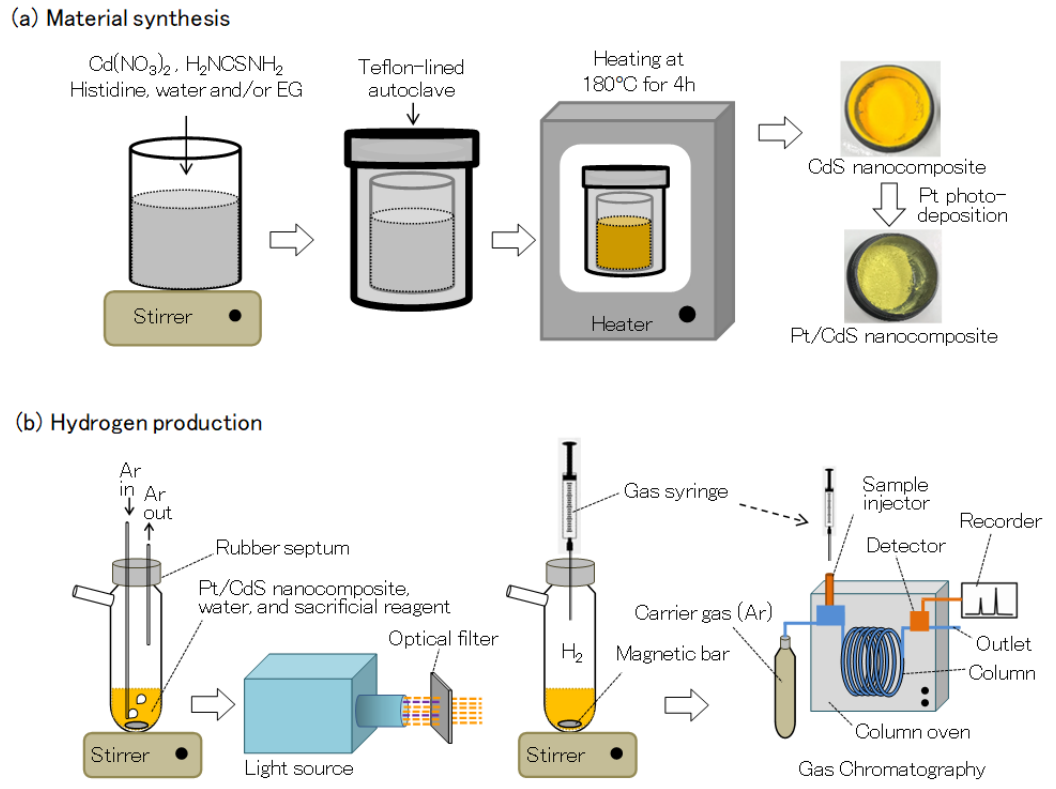
Figure 1. Schematic diagram of material synthesis and H 2 production.